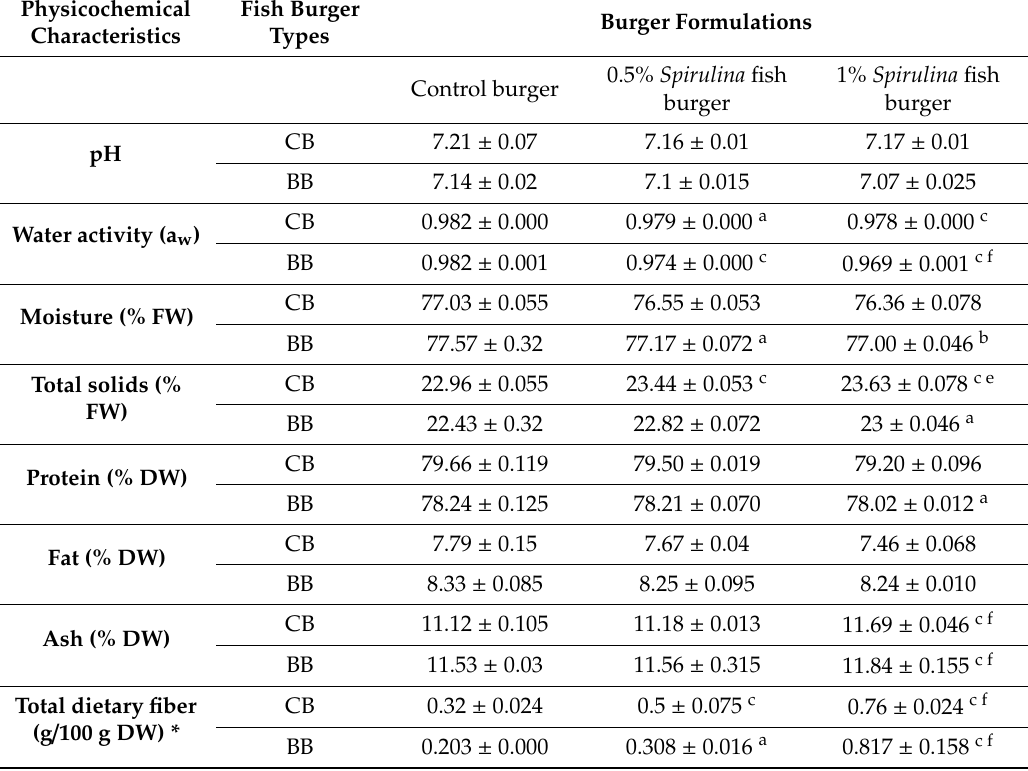
Table 2. Mean values for physicochemical characteristics of control and Spirulina -fortified burgers at one week after